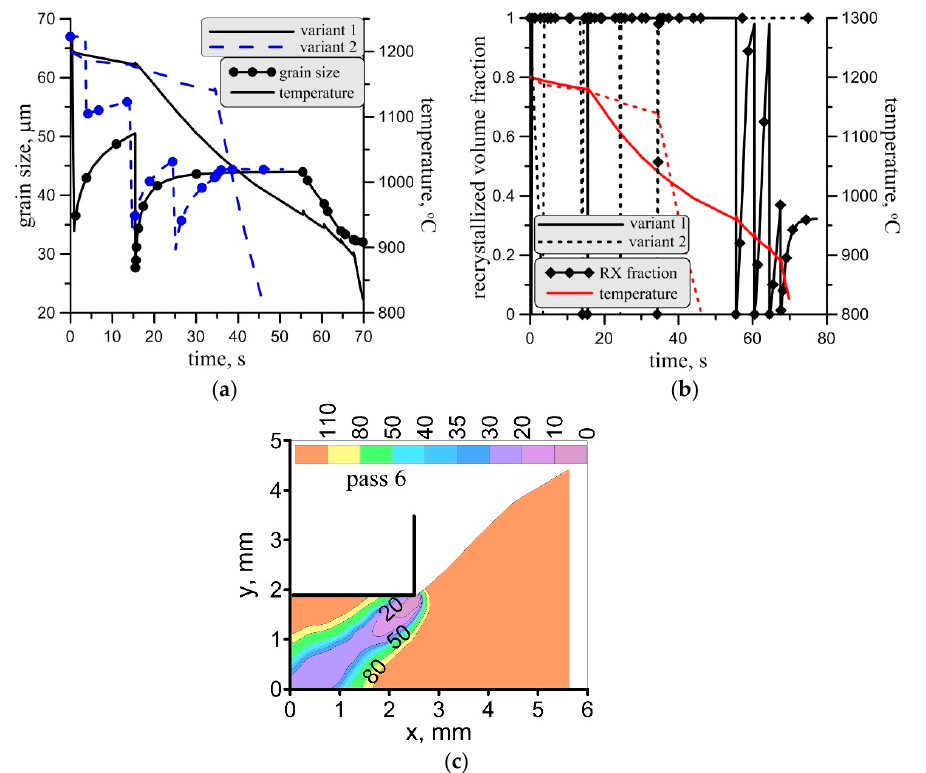
Figure 13. Changes in the temperature and the grain size ( a ) and the recrystallized volume fraction ( b ) in the center of the sample during both investigated variants for bainitic steel and distribution of the grain size after the last pass of the variant 1 ( c ).